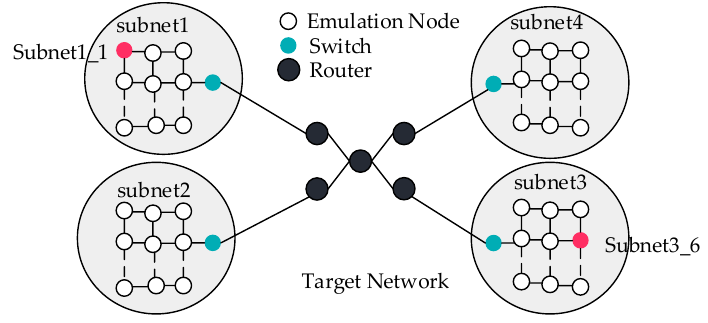
Figure 9. Target network.